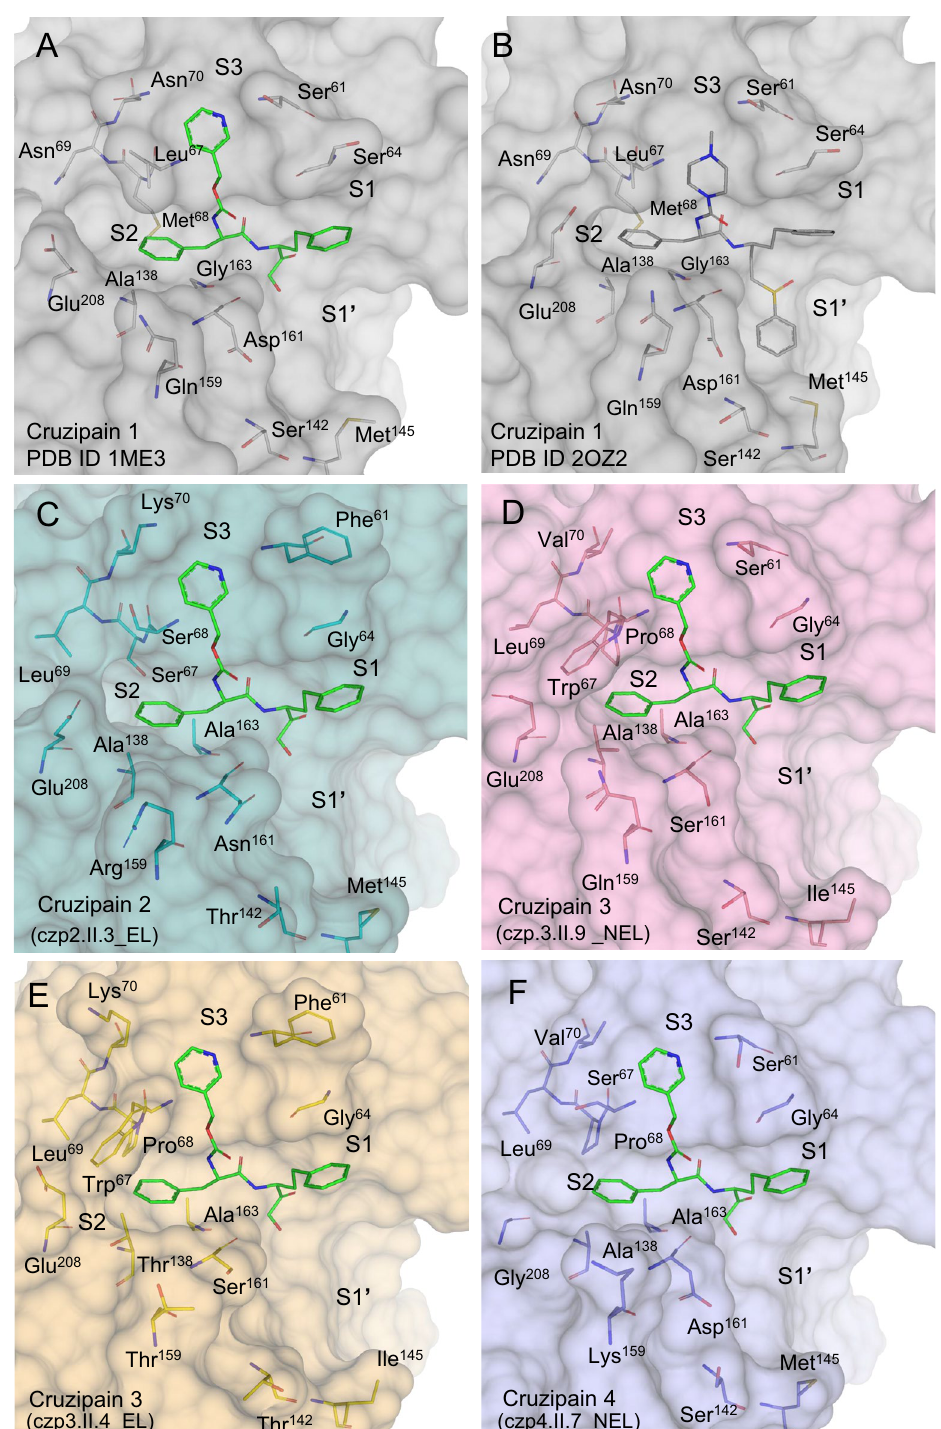
Figure 6. Mutations in cruzipain sequences impact the active site shape and the interactions between the enzyme and its ligands. ( A ) Cruzain (cruzipain 1 sub-type) from PDB 1ME3, in complex with a hydroxymethyl ketone inhibitor, the template for modeling the different sub-types. ( B ) Cruzain (cruzipain 1 sub-type) co-crystallized with K11777 (PDB 2OZ2), a preclinical drug candidate. C-F) Theoretical models for cruzipain 2 (czp.2.II.3_EL), 3 (czp.3.II.4_EL and czp.3.II.9_NEL), and 4 (czp.4.II.7_NEL) with the hydroxymethyl ketone inhibitor from PDB 1ME3. Protein structures are shown as surface and the residues that differ in at least one sub-type as sticks. S1, S1’, S2, and S3 indicate cruzipain subsites. Stick representations are colored by atom, with different colors for carbons in each cruzipain sequence: czp1 (gray), czp2 (light cyan), czp.3.II.9_NEL (pink), czp.3.II.7_EL (yellow), and czp4 (purple). Ligand carbons are represented in green (hydroxymethyl ketone) and gray